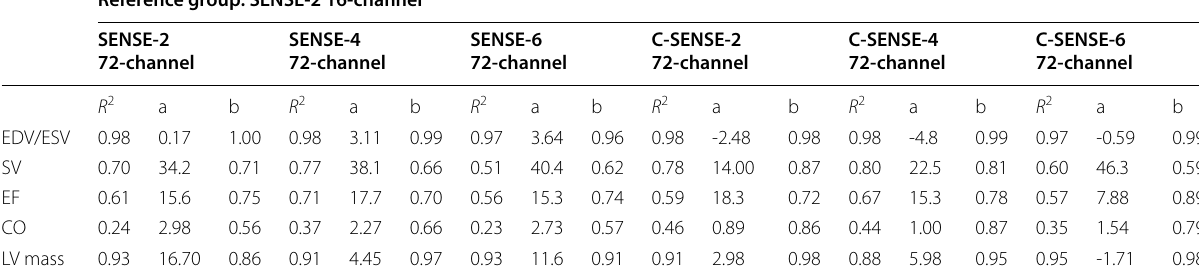
Data are presented as LV and RV variables combined for EDV/ESV, SV, EF, and CO. a intercept, b slope, CO Cardiac output, C-SENSE Compressed sensitivity encoding, EDV End-diastolic volume, EF Ejection fraction, ESV End-systolic volume, LV Left ventricle, RV Right ventricle, SENSE Sensitivity encoding, SV Stroke volume